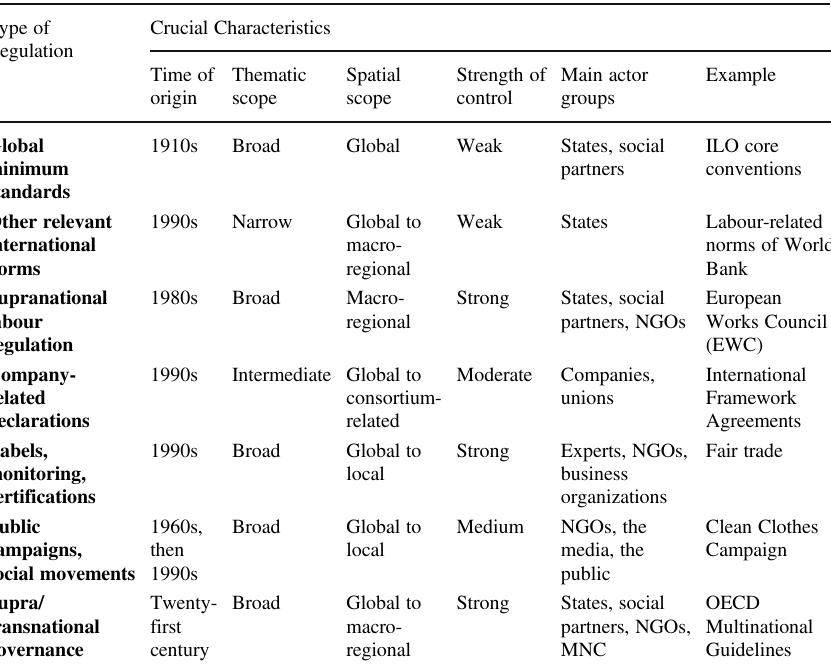
Table 1 Types and characteristics of transnational labour regulation Type of